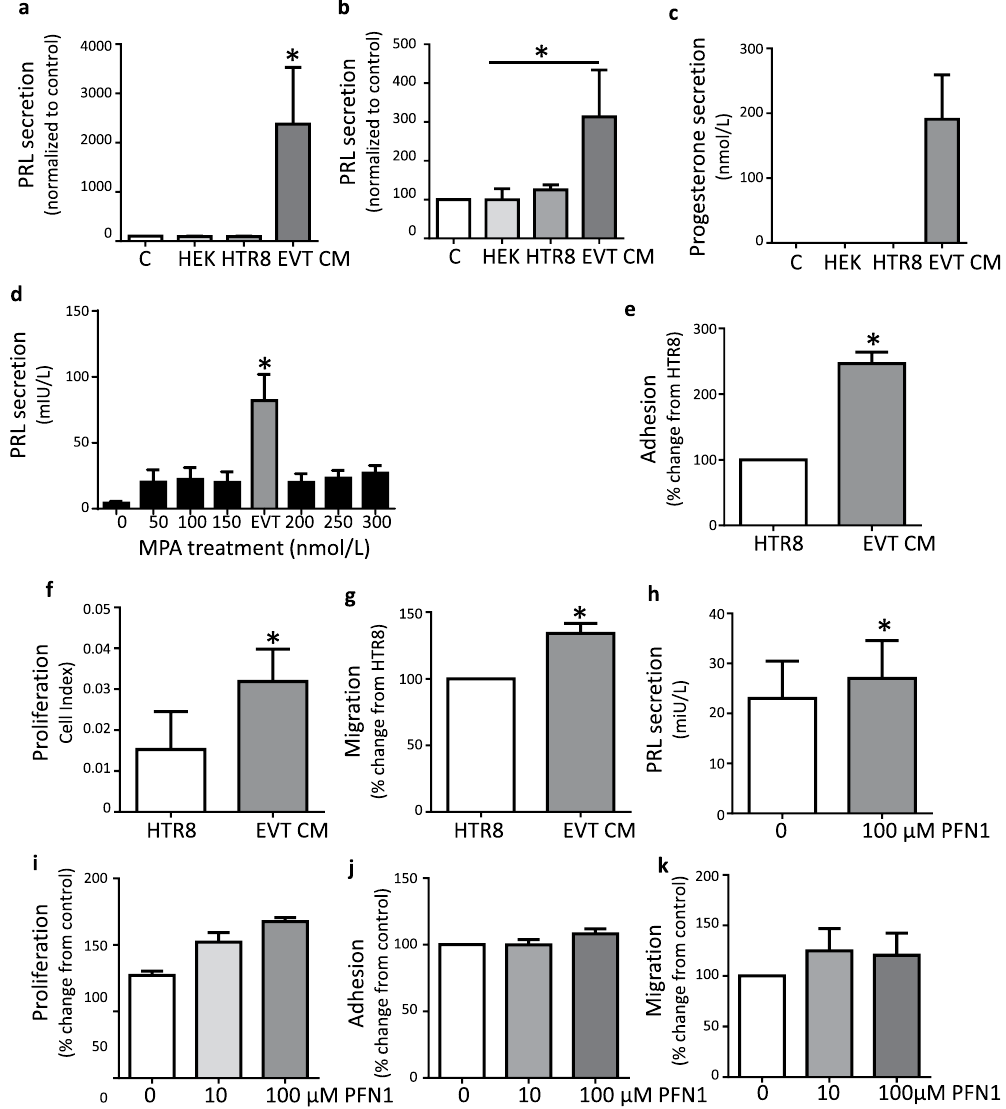
Figure 1. EVT CM enhanced HESC decidualization via profilin 1 (PFN1). ( a ) HESCs (n = 4) were treated with E for 14 days and CM treatments (Hek293, HTR8[/SVneo], EVT) included from day 7. PRL secretion was measured on day 14. PRL secretion was significantly elevated by factors in EVT CM compared to media alone or cell line control CMs. ( b ) HESCs (n = 4) were treated with E + MPA for 14 days with CM treatments (Hek293, HTR8, EVT) included from day 7. PRL secretion was measured on day 14. PRL secretion was elevated in HESC treated with EVT CM compared to Hek293 control CM but not significantly changed compared to media alone or HTR8/SVneo CM. ( c ) Only EVT CM contained progesterone (n = 5). ( d ) PRL secretion by HESC was significantly higher when treated with EVT CM compared to a range (0–300 nmol/L) of MPA concentrations (n = 3/group). ( e–k ) HESCs were decidualized with E + MPA for 12 days before being subjected to functional assays with CM or PFN1 treatments. ( e – g ) Decidualized HESC adhesion (e, n = 3), proliferation (f, n = 4) and migration (g, n = 6) were significantly enhanced by treatment with EVT CM. ( h ) PFN1 treatment during decidualization (days 7–14 of E + MPA treatment) significantly increased HESC PRL secretion on day 14 (h, n = 4). i . PFN1 treatment significantly enhanced proliferation of decidualized HESC (n = 3). ( j,k) PFN1 treatment had no effect on decidualized HESC adhesion (j; n = 3) or migration (k; n = 4). Data are mean ± SEM, * p < 0.05, significant difference from control; ^p < 0.05 significant difference between treatments labelled with ^. a,b,d: Friedman test; d,e,f,g,h: paired t-test; i, j,k: repeated measures one-way